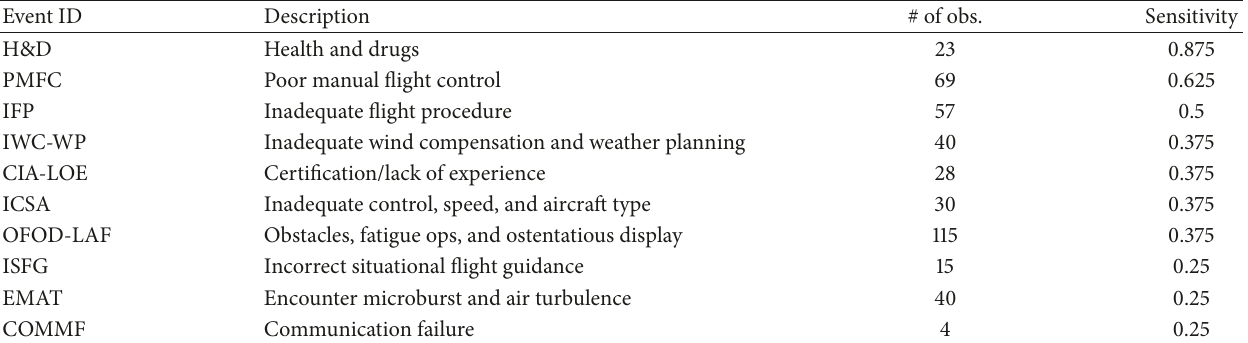
Table 5: Combined influenced top ten events sensitivity results for accident data.